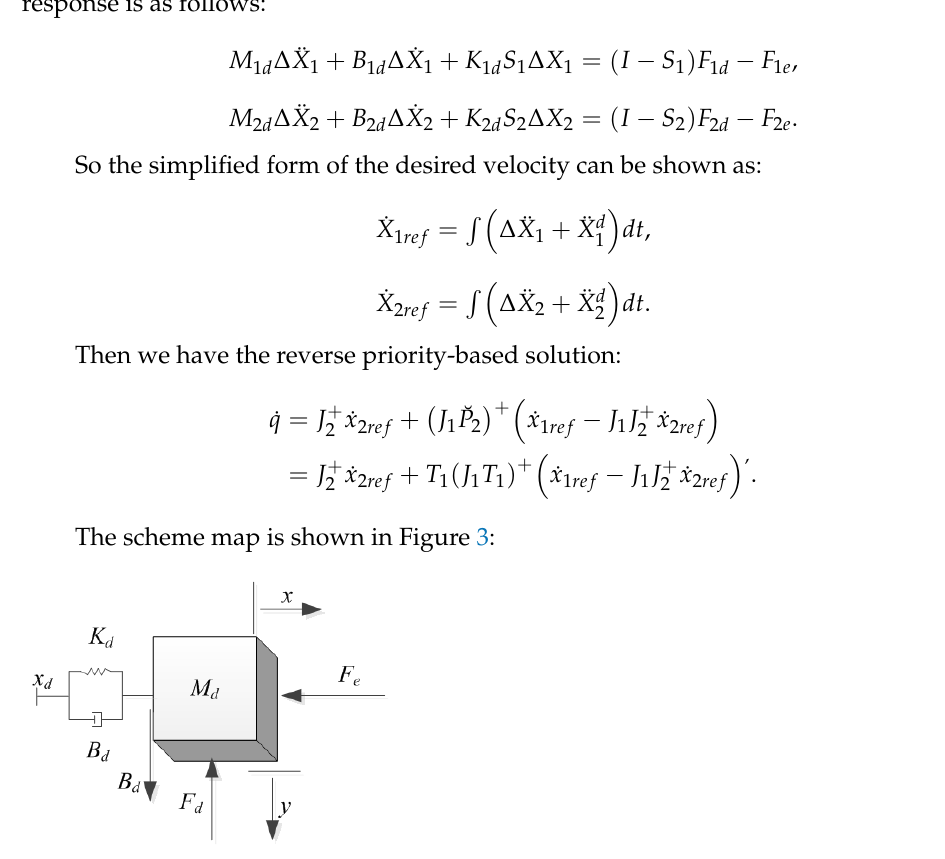
Figure 3. The dynamics of the hybrid impedance